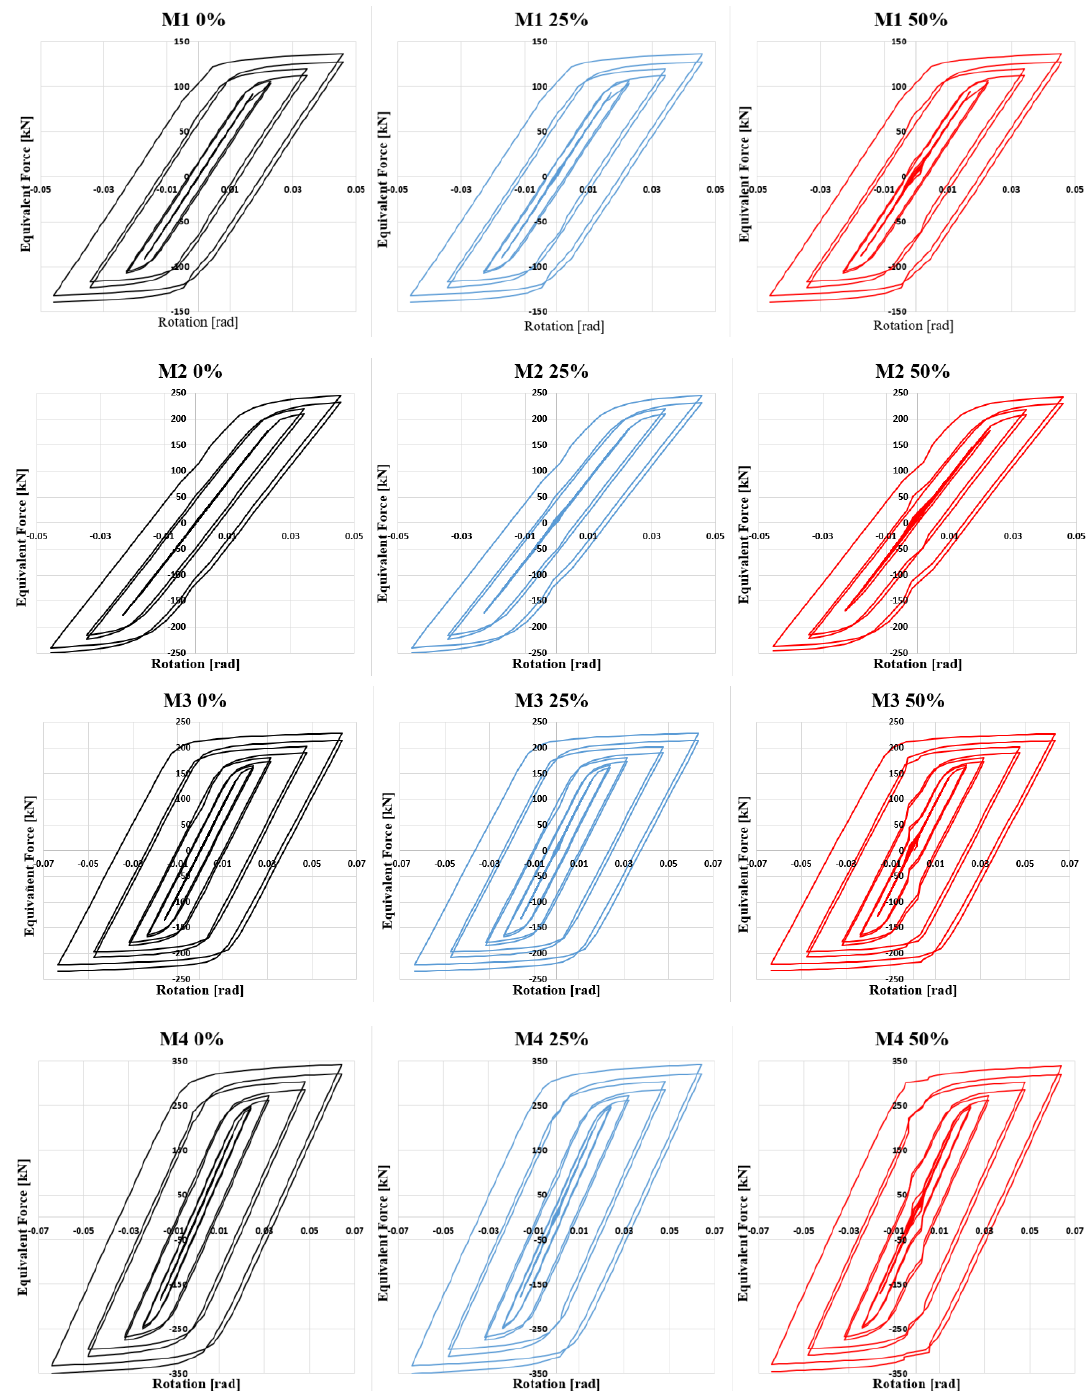
Figure 6. Equivalent force-rotation curves for the configurations studied.